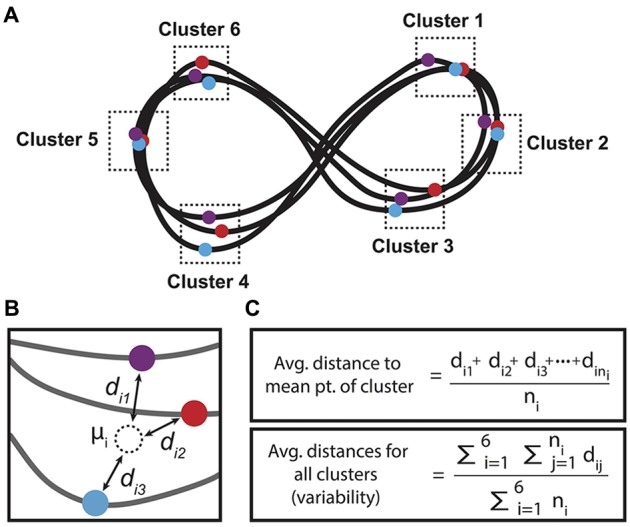
Method for calculating figure 8 variability, or drawing quality. (A) Figure 8s were divided into six clusters where the x- or y-coordinate met a maximum or minimum value for each individual figure 8 drawn per trial. (B) Within each cluster, a mean point was calculated, and the average distance of the cluster’s extreme points to the mean point was calculated. (C) Formula used for calculating the average distance to the mean point of each cluster and the average distances for all clusters, or the variability value per trial. Note that ni is the number of points in the i-th cluster.